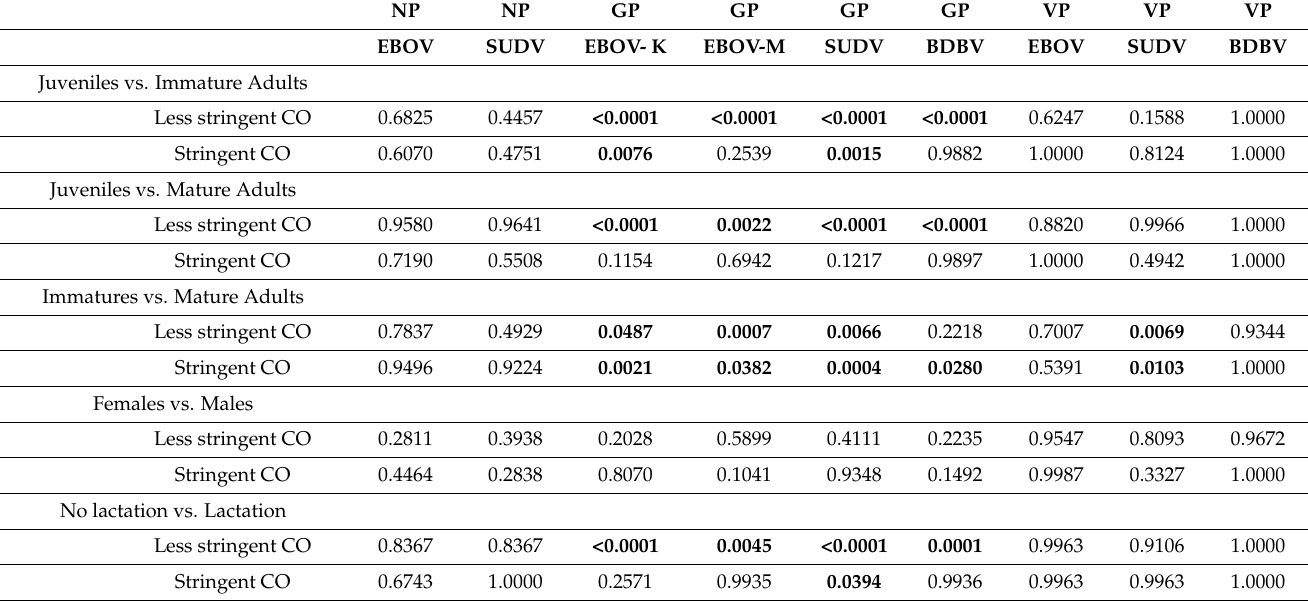
Table 3. p -values calculated as described in methods to compare differences in antibody positivity according to age, sex and lactation for females with stringent (statistical methods. see methods) and less- stringent (4 × SD of negative samples) cut-off values. The assay used recombinant proteins of Nucleoprotein (NP). Viral Protein-40 (VP40) or Glycoprotein (GP) for different Ebolavirus lin- eages: Zaire (EBOV). Sudan (SUDV). Bundibugyo (BDBV) and Reston (RESTV). GP proteins from the Mayinga (GP-M) and the Kissidougou (GP-K) strain were used for EBOV. p -values < 0.05 are highlighted in